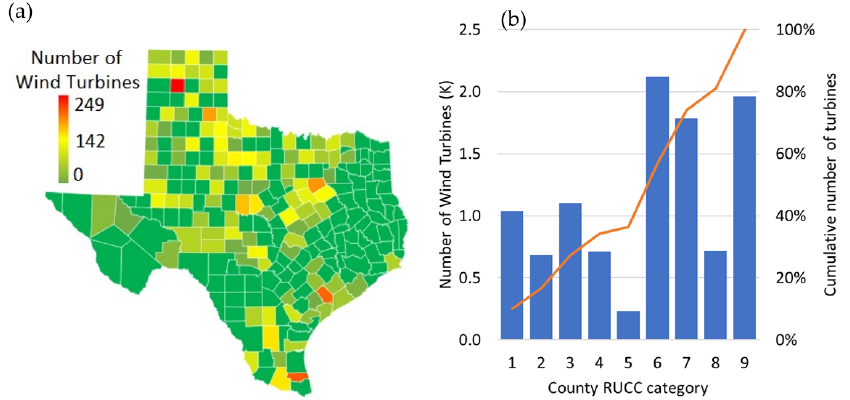
Figure 16. Assessment of ERCOT’s future proposed wind farms for Texas. ( a ) Map of proposed future wind turbines per county, ( b ) Number of proposed future wind turbines per counties categorized by USDA